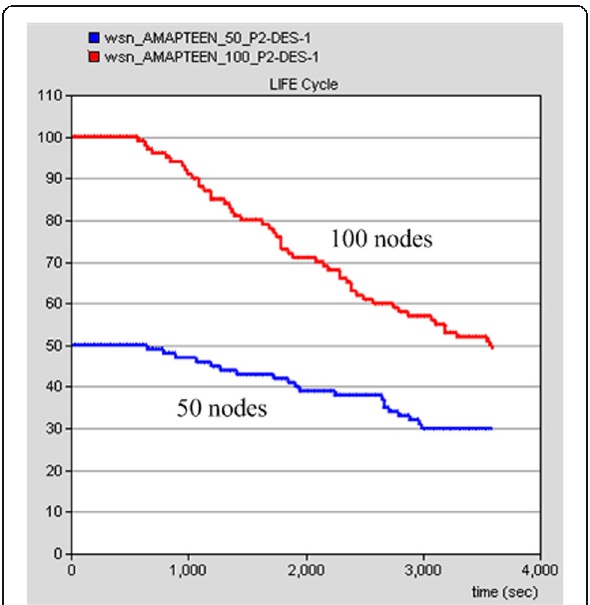
Fig. 12 Comparison of a life cycle between APTEEN and ADCAPTEEN. The comparison of a life cycle under APTEEN and ADCAPTEEN routing protocol is shown in this figure. This figure shows that about after 450 s, APTEEN begin node dies. In about 3600 s, most nodes run out of energy, with only a few nodes surviving. ADCAPTEEN begin node dies in about 500 s, and about after 3600 s, ADCAPTEEN have many nodes alive. Compared with